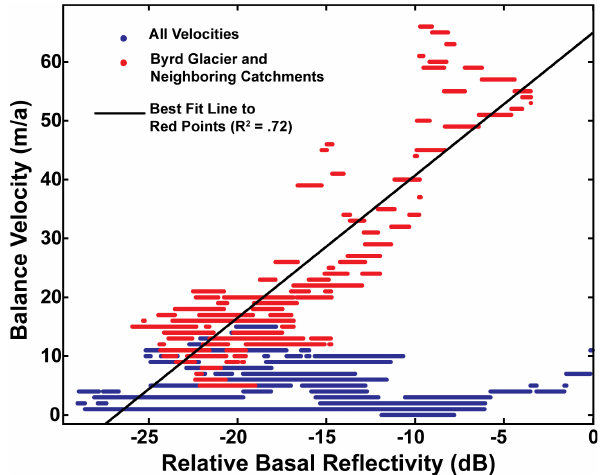
Fig. 5. Scatter plot showing the correspondence between basal re- flectivity and balance velocities. Velocities are gridded to 5km. Re- flectivity has been smoothed to show features with a spatial scale of 5km or greater. Points in red are limited to portions of the traverse in or around the Byrd Glacier Catchment (organized flow) shown in Fig. 1. Blue points are balance velocities compared to reflectivity for the entire traverse. The black line is a least squares regression to only the organized flow (points in red) with an R 2 = 0 .